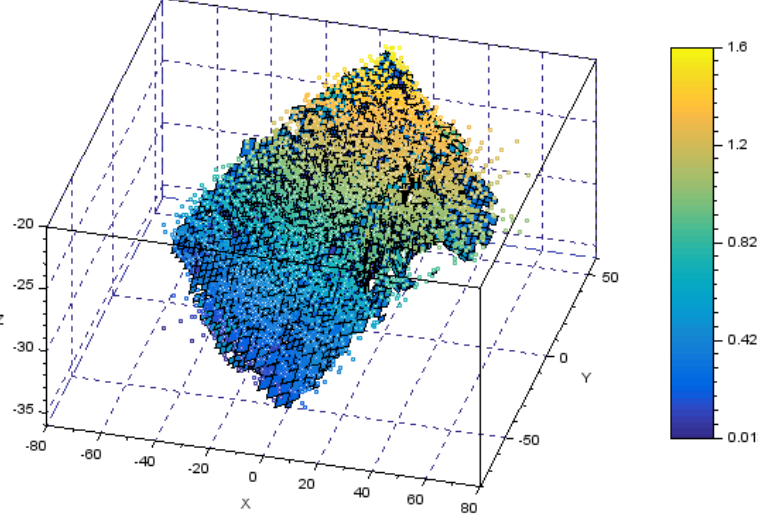
Figure 10. LIBAC data selection with propagation of the CSMU. The point cloud is colored according to its elevation, and surface elements are colored according to their sensitivity function, as defined by the color